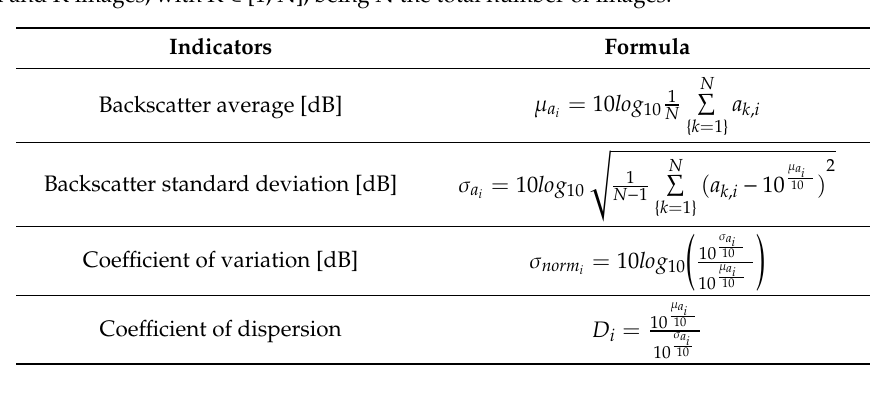
Table 2. Formulas of the four selected indicators of SAR derived information employed as input in the land use / land cover (LULC) classifier. Each index is calculated within the temporal data series of each pixel i and K images, with K ∈ [1, N], being N the total number of